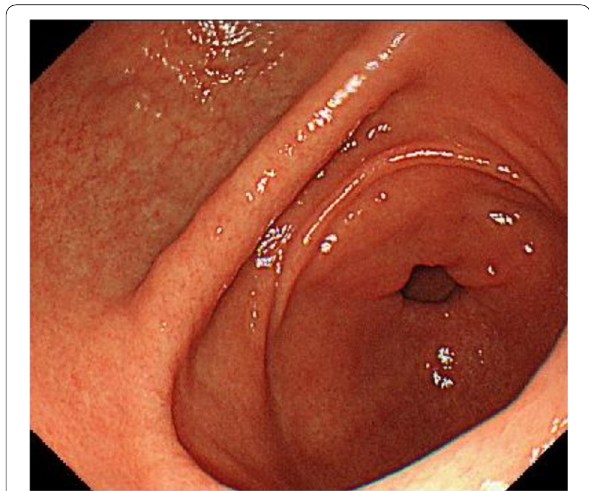
Fig. 3 Findings of upper gastrointestinal endoscopy. The endoscopic findings were normal and did not show an submucosal tumor like mass as seen in an ectopic pancreas